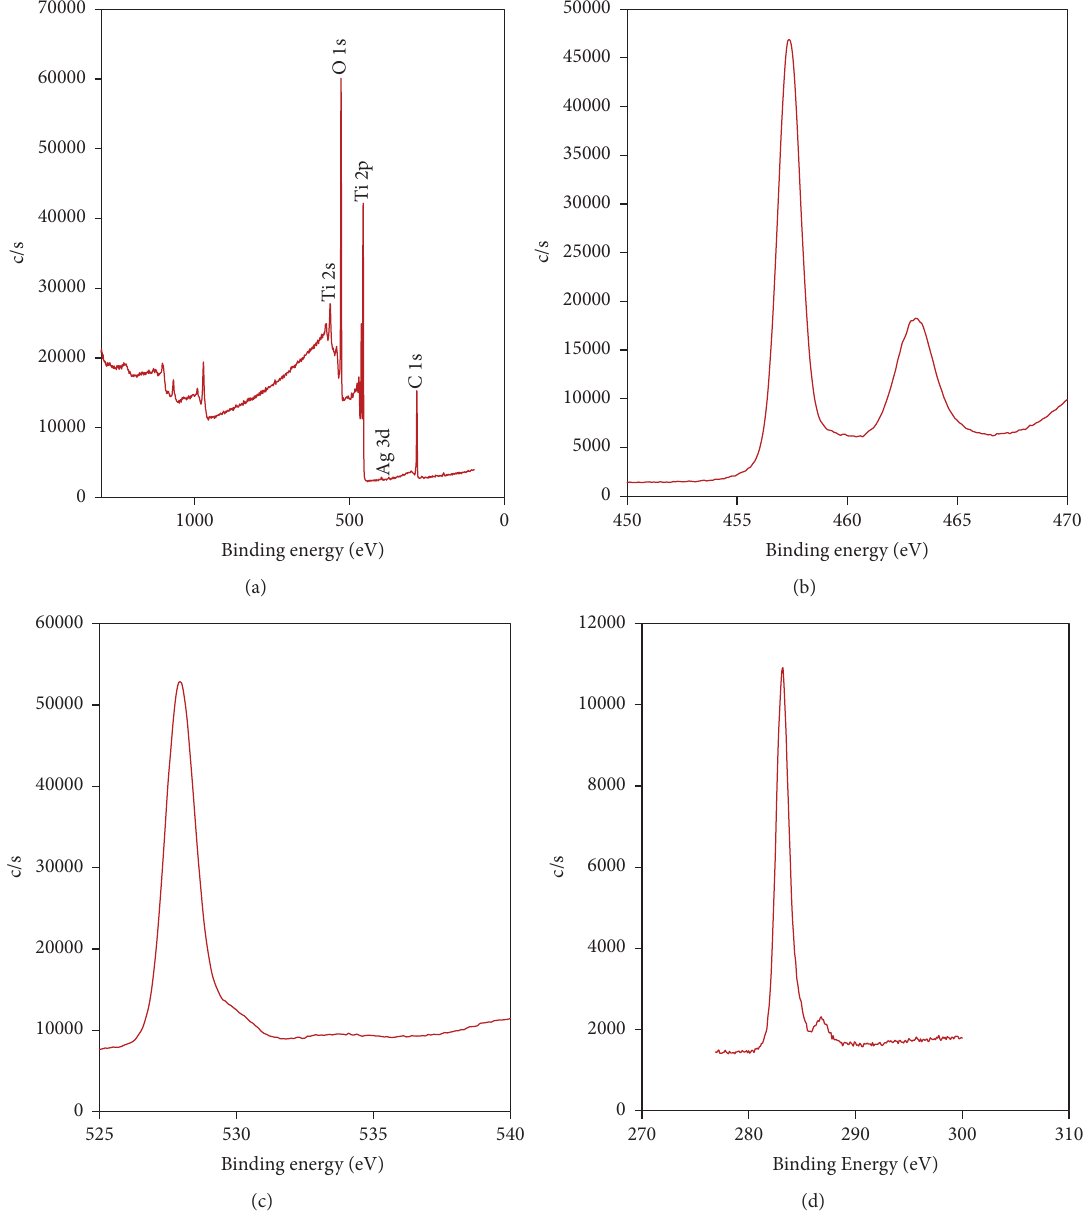
Figure 7: XPS spectra of Ag/C codoped TiO 2 (0.5% Ag) photocatalyst; (a) survey scan, (b) Ti 2p, (c) O 1s, and (d) C